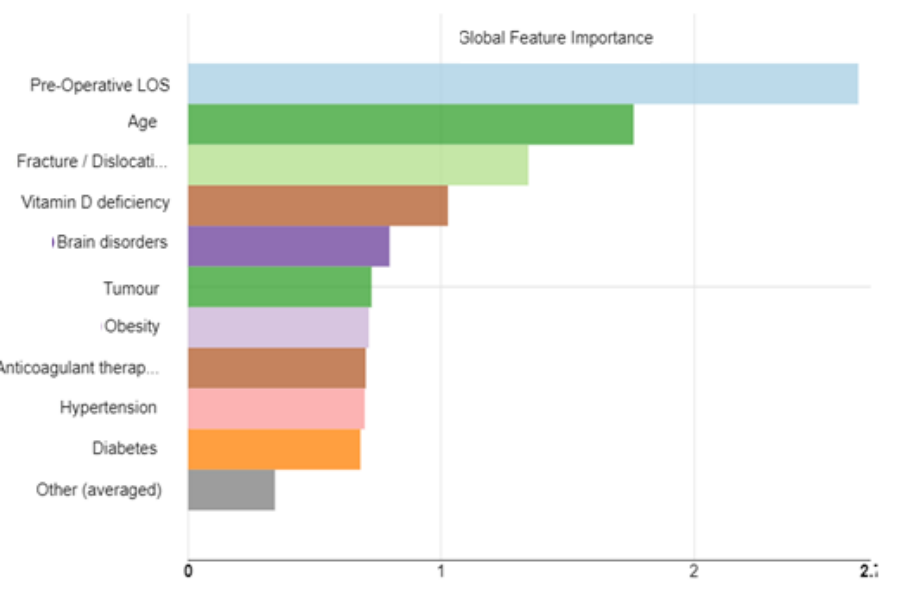
Table 7. Analysis of COVID-19 impact.